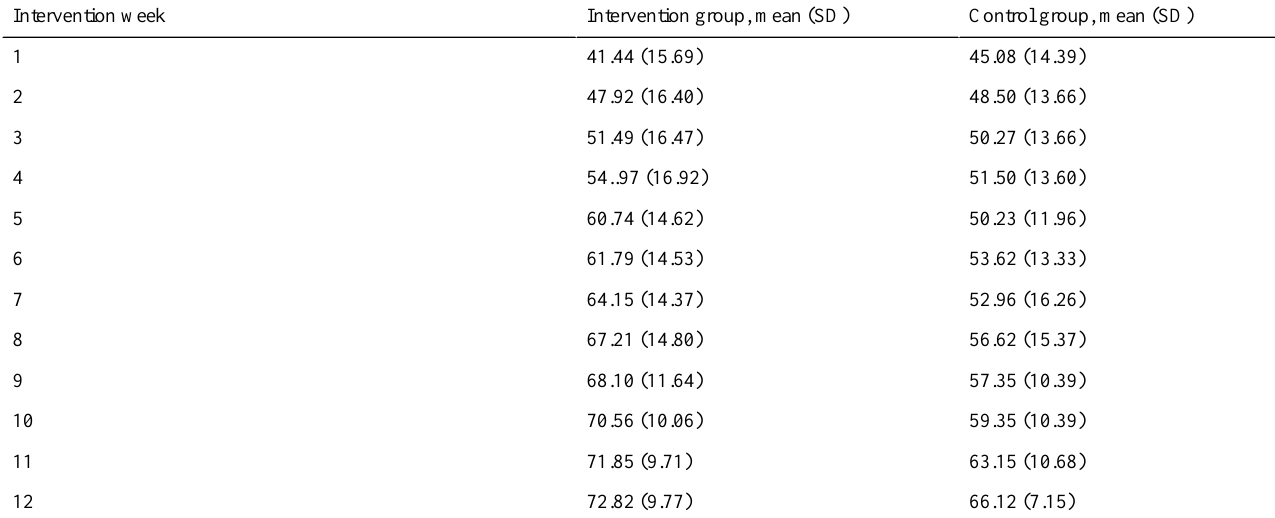
Table 2. Self-Report Habit Index characteristics based on group.